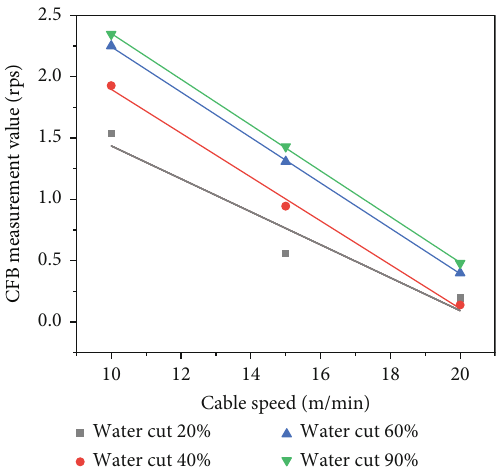
Figure 14: Relational graph of the measured value of 85 ° inclination of 300 m 3 /d CFB and cable speed.